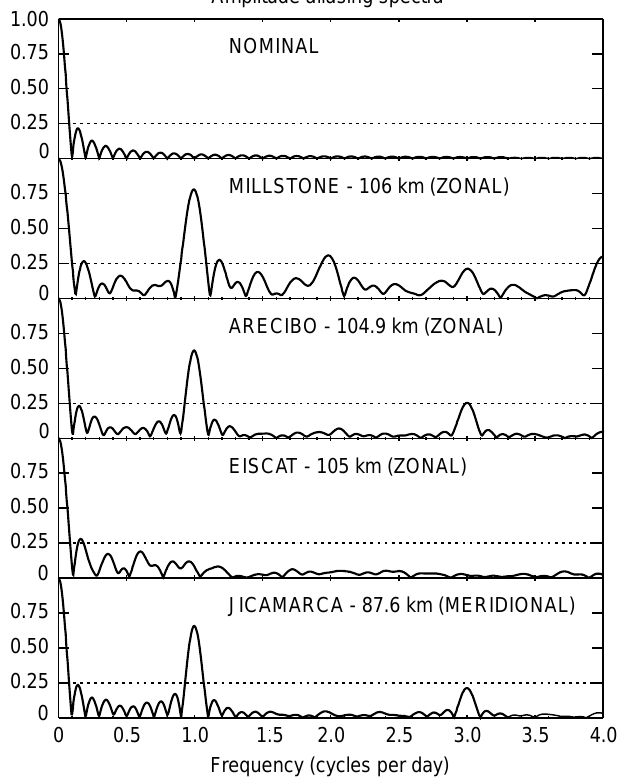
Fig. 2. An example of the aliasing spectrum which results from nonuniformly sampling the observed time- series. The aliasing spectra are shown for the nominal case when the time-series is uniformly sampled (top), the Millstone Hill zonal winds at 106 km (second from top), the Arecibo zonal winds at 104.9 km (third from top), the EISCAT zonal winds at 105 km (fourth from top), and the Jicamarca meridional winds at 87.5